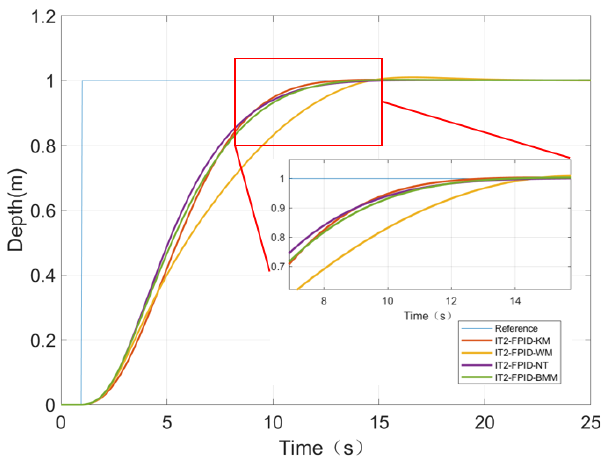
Figure 7. Comparison results of simulation without noise. Table 5. Performance index results without noise perturbations.